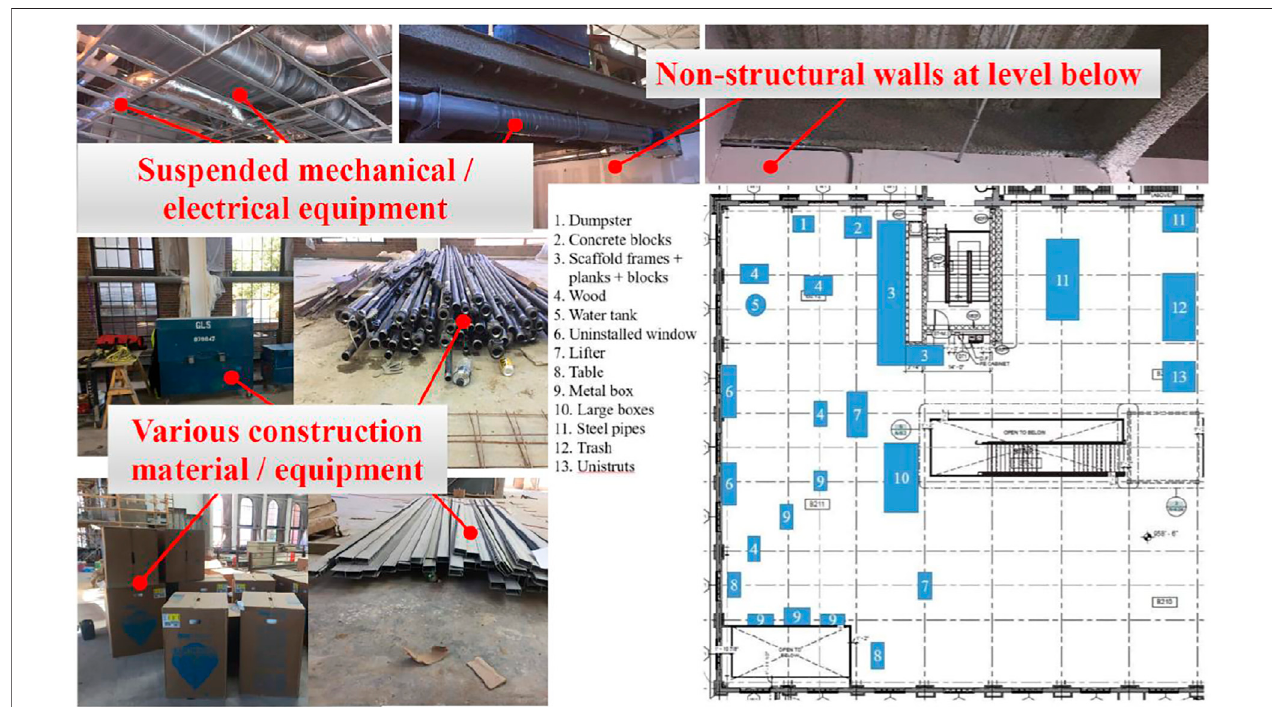
FIGURE 10 | Non-structural elements; various construction materials present on the test fl oor.